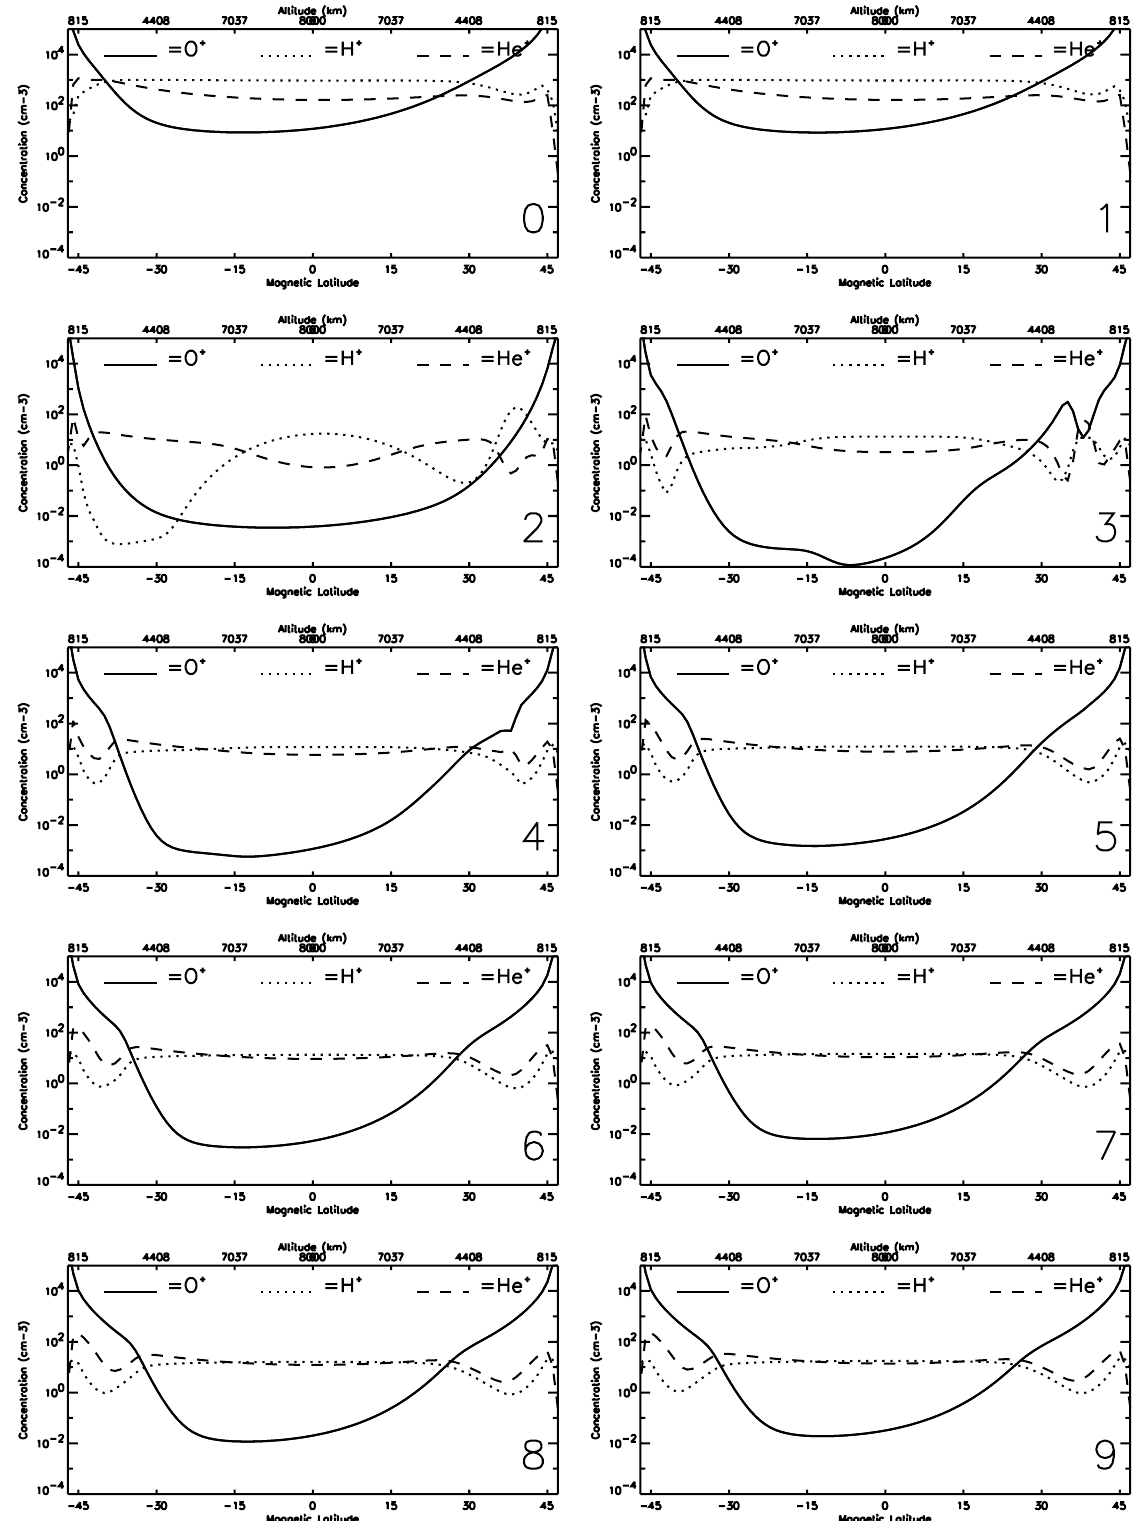
Fig. 6. Examples of periods when the He + ion is dominant, or comparable with the O + ion in the trough region. These plots show data from the period when the plasmasphere is either disturbed, or recovering from disturbed conditions (4, 22, and 29 June, respectively). Such examples are typical of He + dominance in the trough region which occurs during the recovery period throughout the month of